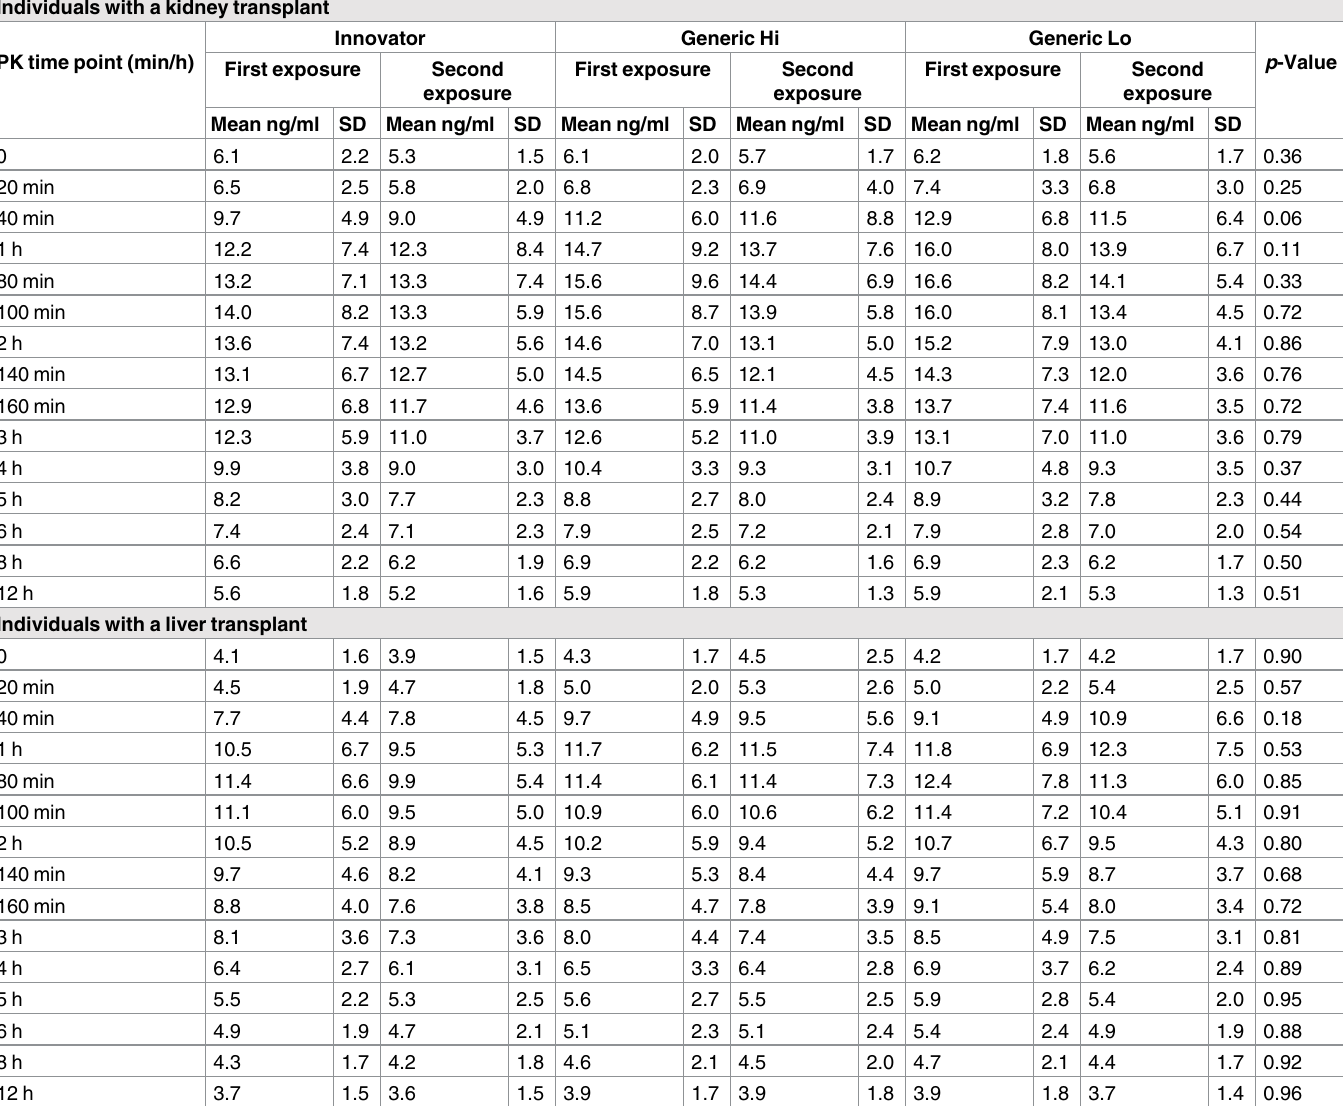
Table 2. Tacrolimus level results at each time point for individuals with a kidney or liver transplant. Individuals with a kidney